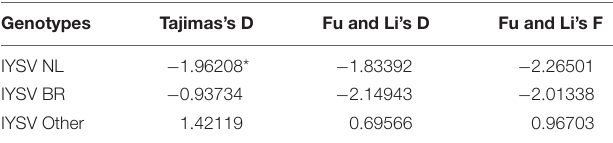
TABLE 4 | Neutrality tests of Iris yellow spot orthotospovirus genotypes based on total number of segregating